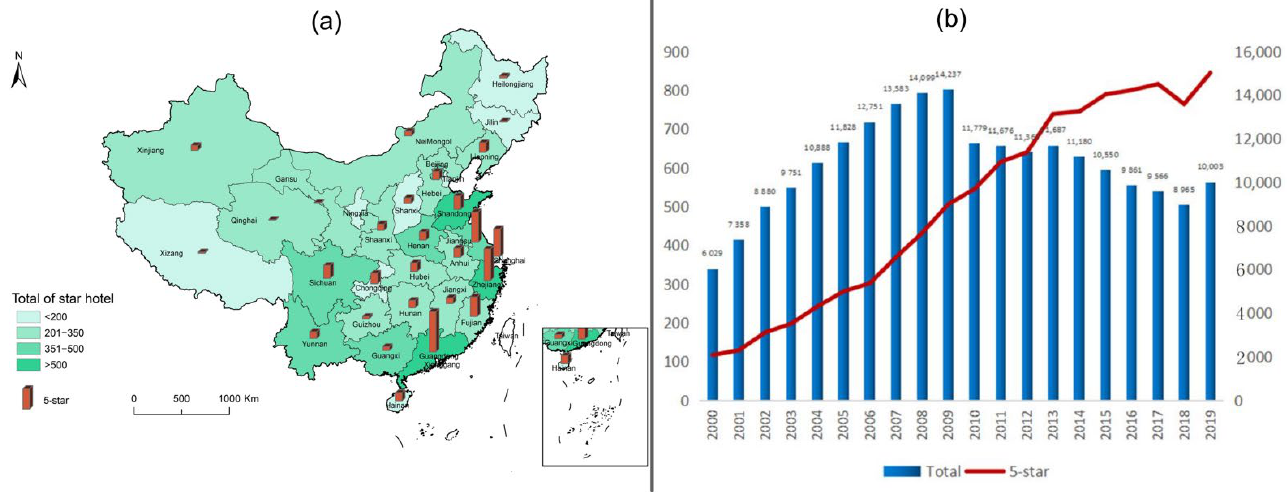
Figure 1. The spatial distribution pattern and quantity change of star hotels and five-star hotels in China. ( a ) number of star hotels and 5-star in 2019; ( b ) number of star hotels and 5-star in 2000– 2019).